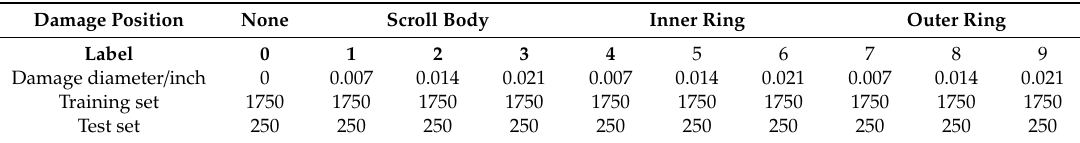
Table 2. The experimental